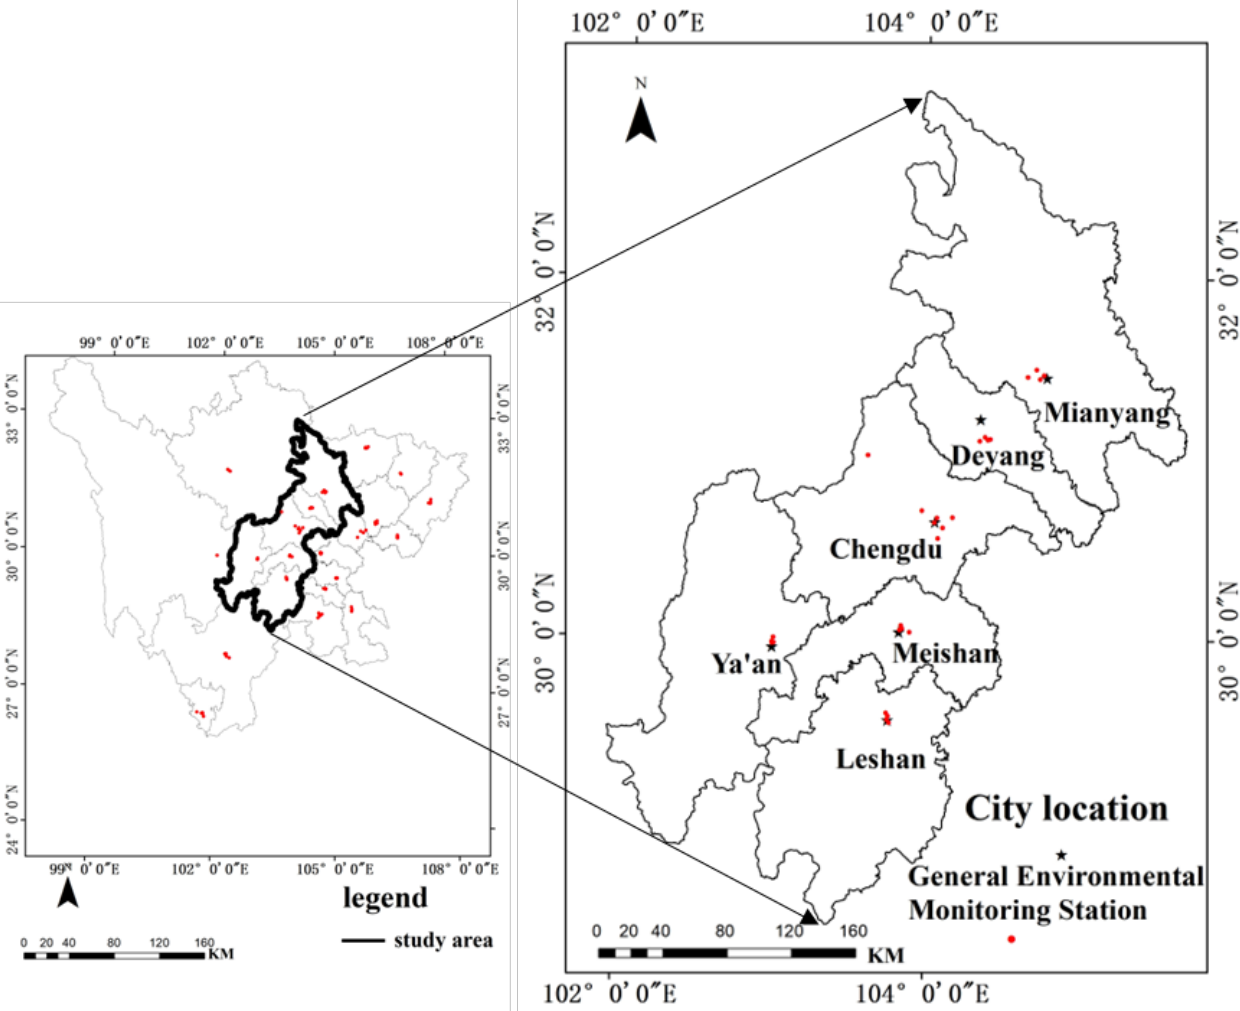
Figure 1. Geographical location of the Chengdu Plain urban agglomeration.